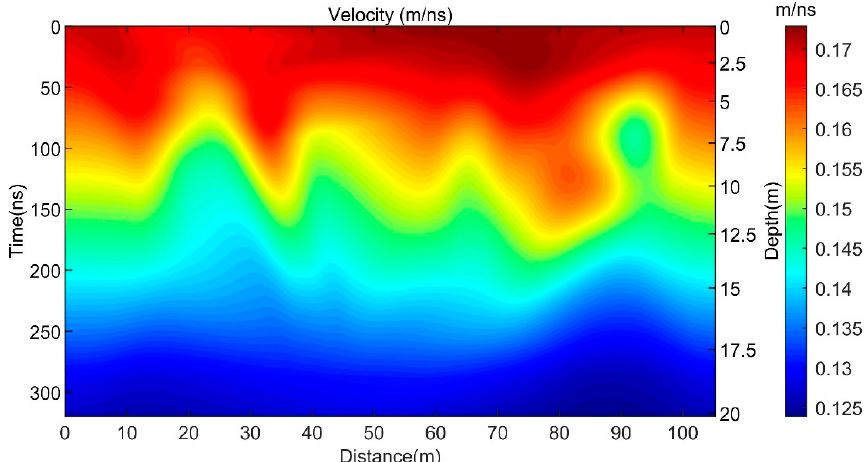
Remote Sens. 2020 , 12 , 629 Figure 11. The subsurface electromagnetic wave velocity structure. Figure 11. The subsurface electromagnetic wave velocity structure.